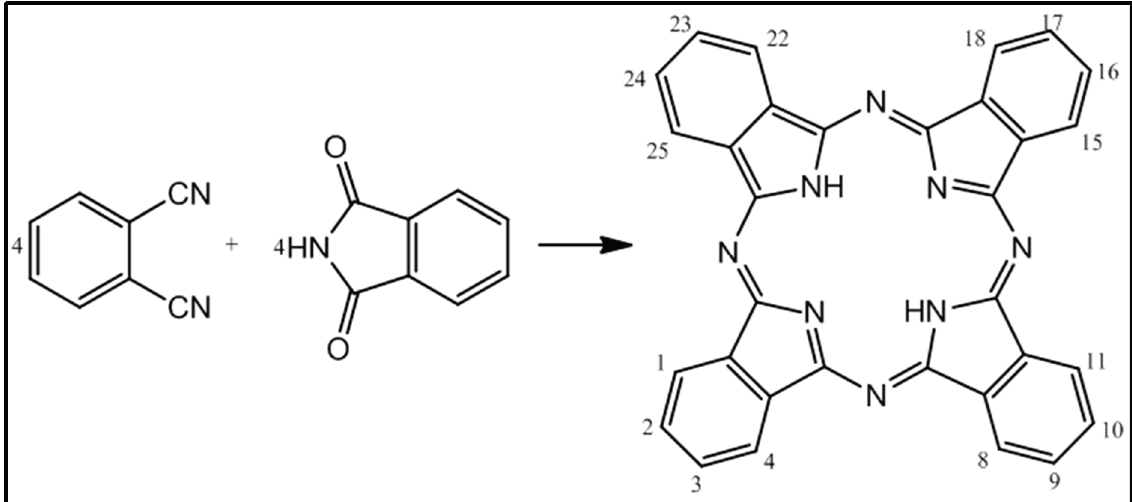
Figure 2. Synthesis of phthalocyanine (PC). The O -cyanobenzamide reacts with